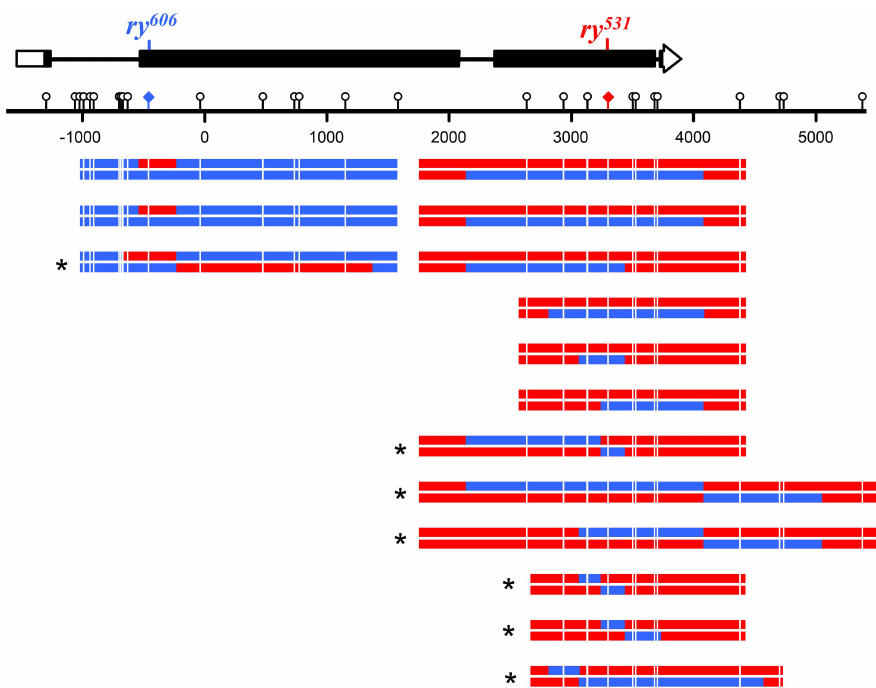
Figure 4. Noncrossovers from Xpc ; Msh6 mutants. At the top is a schematic of the rosy locus and the location of the mutant alleles used for purine selection (see Figure 3 and Materials and Methods). Each pair of lines below the scale represents the two strands of an independent noncrossover recombinant chromosome (red, sequence from ry 531 chromosome; blue, sequence from ry 606 chromosome). Markers used to map hDNA tracts are indicated with lollipops on the scale bar and white lines on the recombinants. Tract ends are shown as the halfway point between the last marker included in the tract and the first marker not in the tract. The two tracts at ry 606 that contain only a single marker were not included in the trans/cis analysis. Asterisks indicate tracts with trans hDNA.